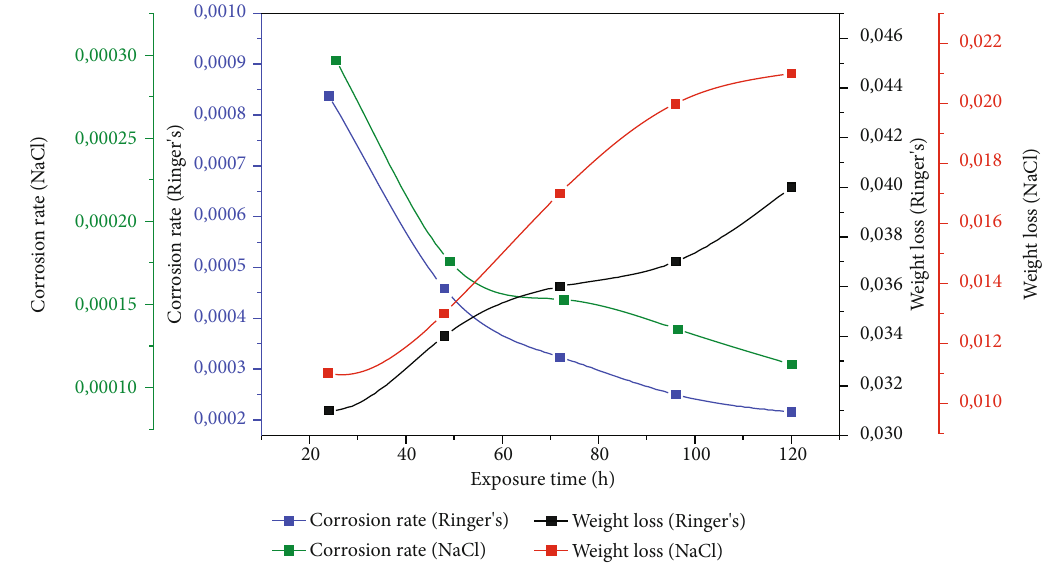
Figure 5: Weight loss experiment results: corrosion rate versus exposure time and weight loss versus exposure time.